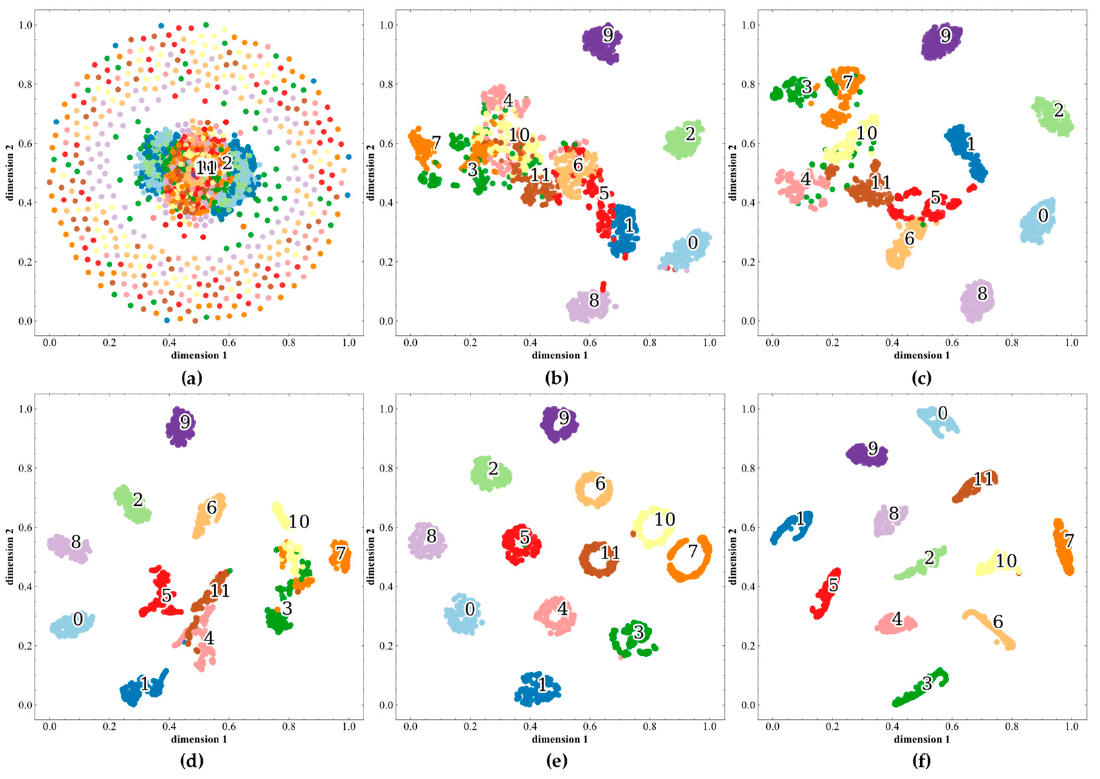
Figure 12. SRMANet Middle Layer Visualization. ( a ) Input layer ( b ) Conv block1 output ( c ) Conv block2 output ( d ) Conv block3 output ( e ) Attention unit output ( f ) The last layer